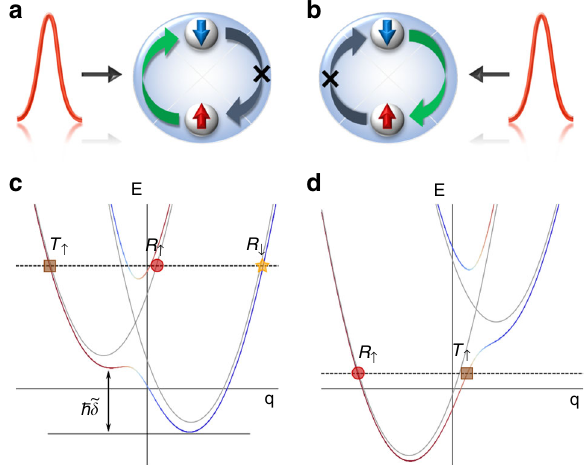
Fig. 1 General concept and mechanism of a one-way spin switch. A control signal incoming from a the left or b the right is able to switch the spin orientation of the system from ↑ to ↓ ( a ) or ↓ to ↑ ( b ) while the reverse processes are forbidden. Sketch illustration of the spin switch and unidirectional mechanism in the comoving frame with c positive or d negative barrier velocity. Band dispersions with (red and blue) and without (gray) SO coupling are plotted. We assume an initial state with majority in spin-up state | ↑ 〉 (red curve), labeled by the brown squares. Three channels are labeled: spin-preserved transmission ( T ↑ ), spin- preserved re fl ection ( R ↑ ), and spin- fl ipped re fl ection ( R ↓ ). The tilt of the dispersion represented by ~ δ is given by a combination effect of the Raman detuning in the lab frame and the Doppler shift, proportional to the velocity of the barrier, in the comoving